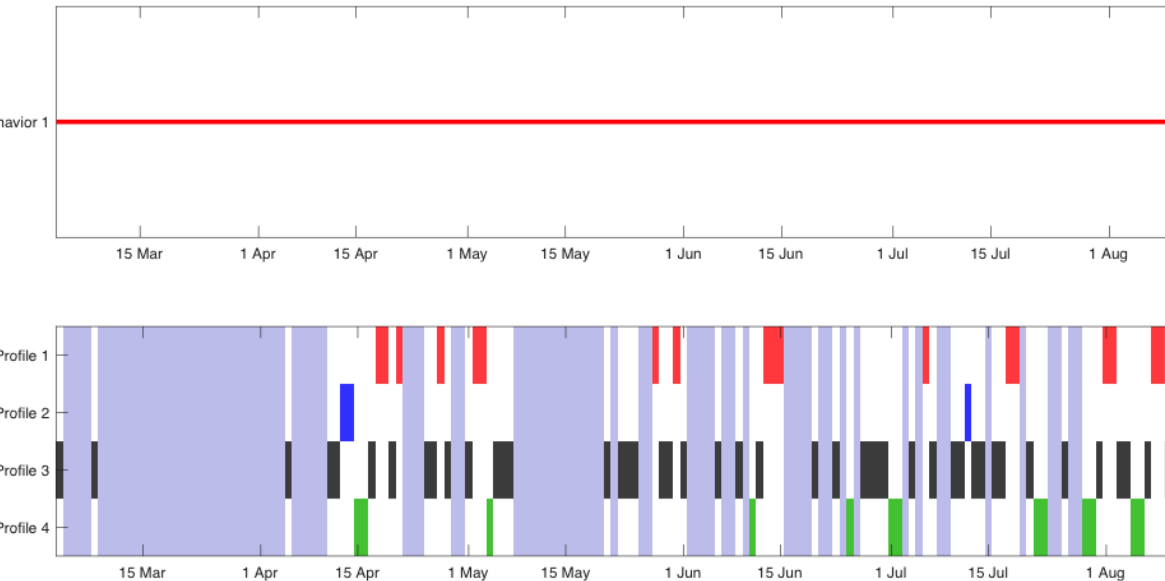
Figure 10. Representation of mobility pattern changes (above) identified by the technique and corresponding patterns (down) during study participation of patient